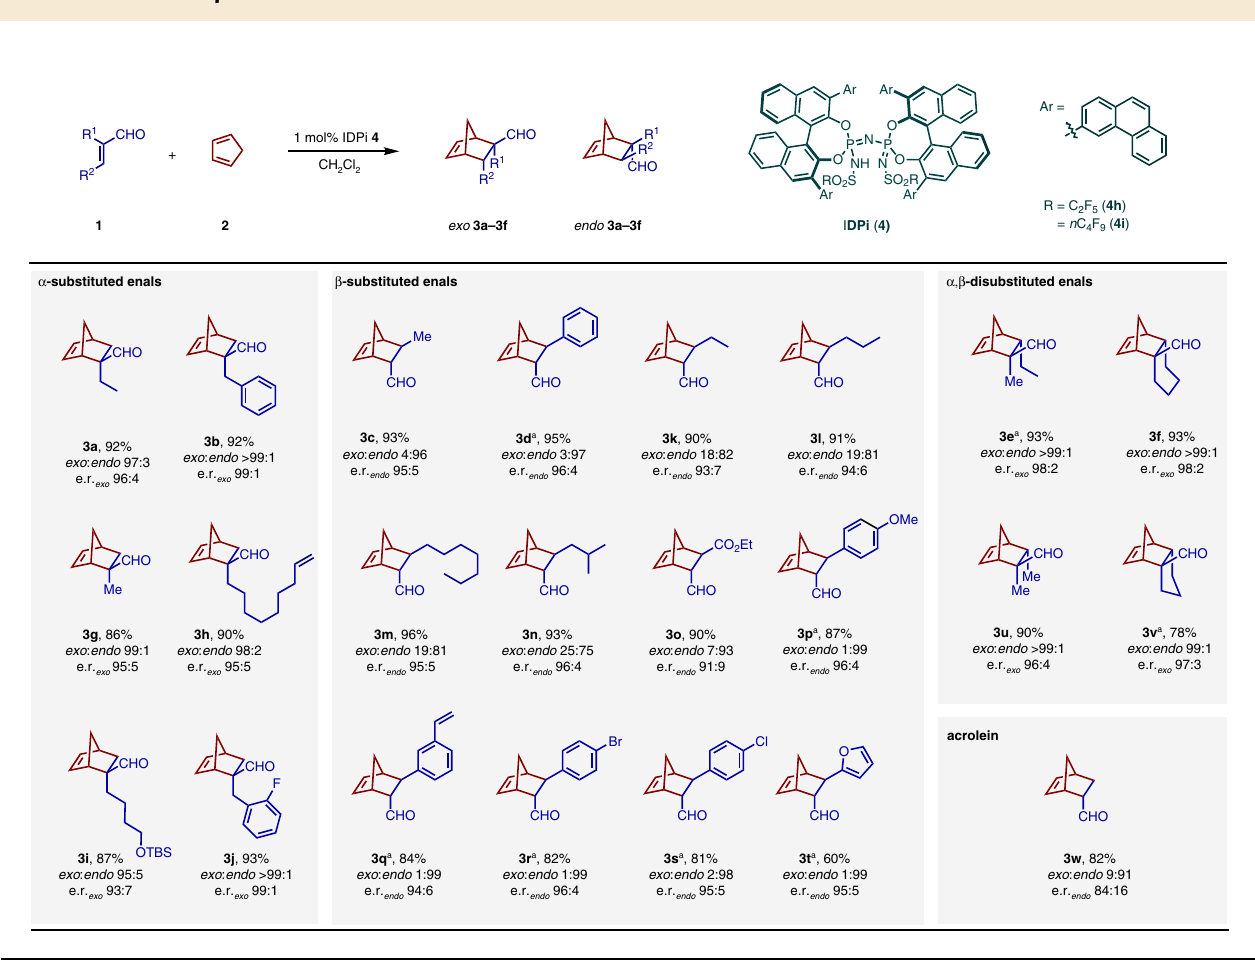
Table 1 Substrate scope of the Diels – Alder